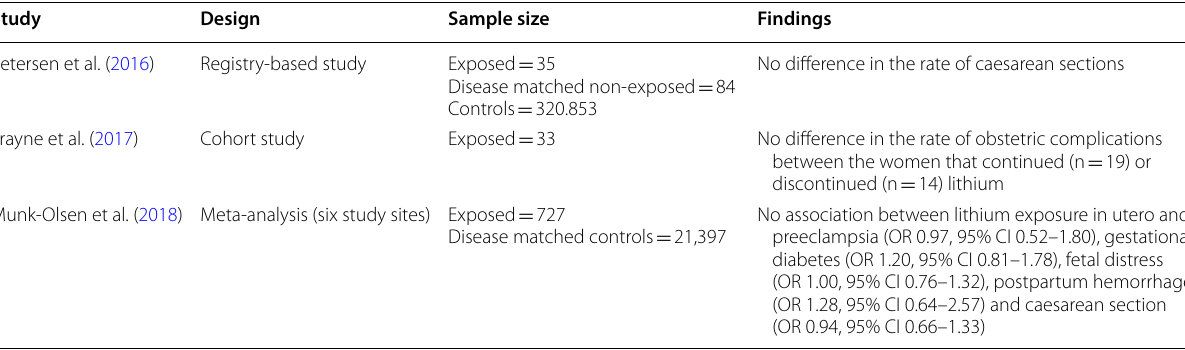
OR odds ratio, CI confidence